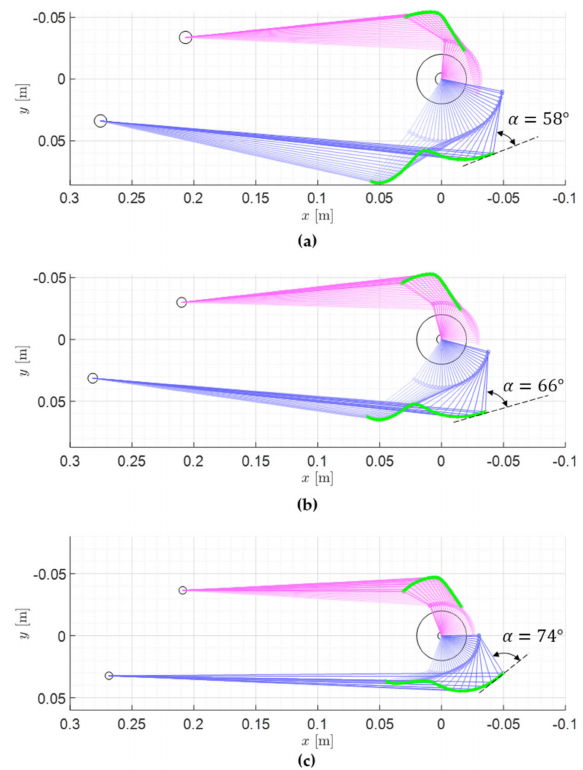
Figure 10. Three designs from the pareto-front: ( a ) design A; ( b ) design B; ( c ) design C. Mechanisms 1 and 2 are shown in blue and magenta, respectively. The guide groove profiles are shown in